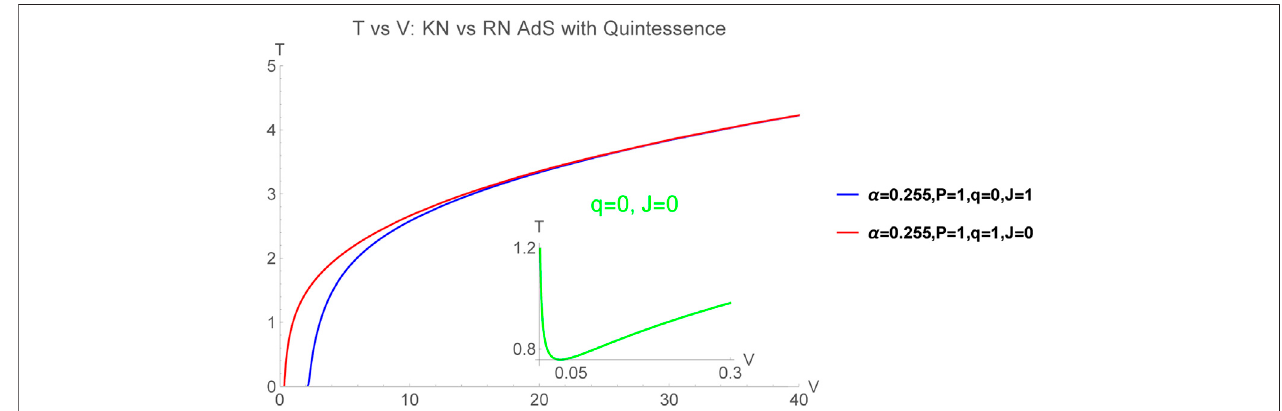
FIGURE 1 | Plot of the Hawking temperature vs thermodynamic